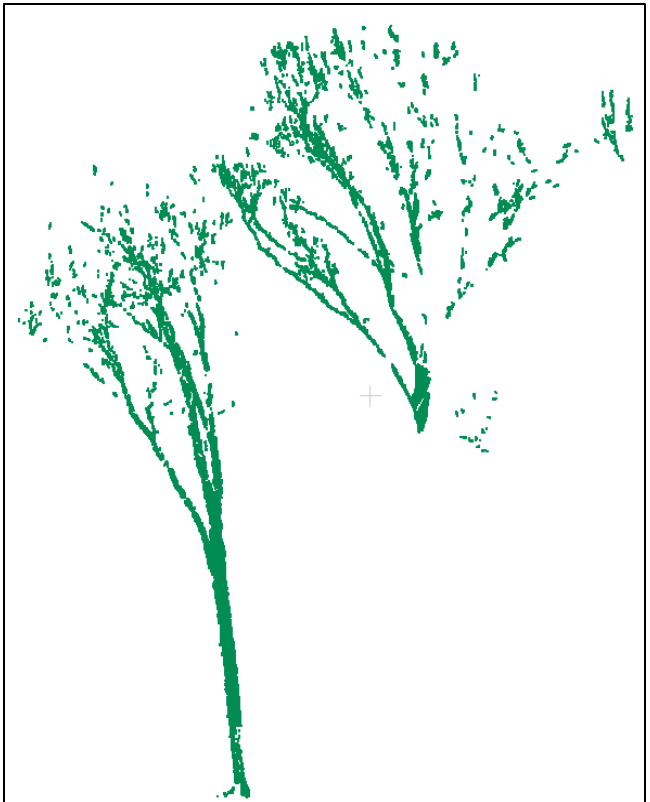
Figure 8. The ‘detached tree’ artifact. Two trees are segmented as a single tree because the trunk of the right tree is missing from the data.